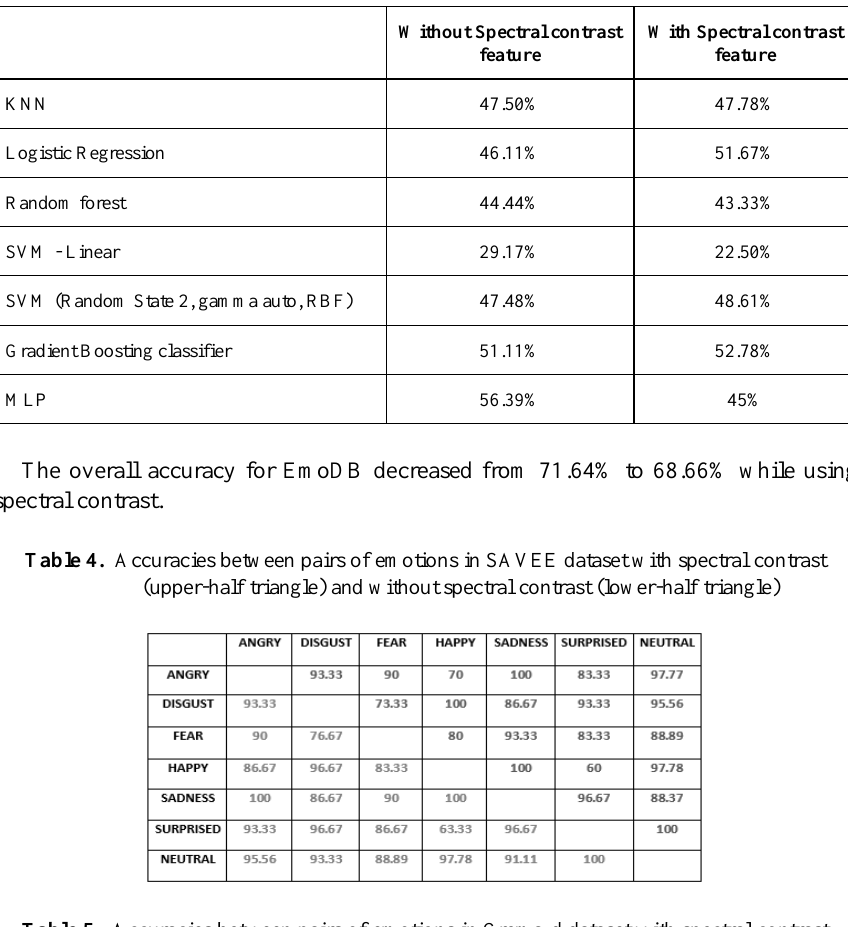
Table 5. Accuracies between pairs of emotions in Crema-d dataset with spectral